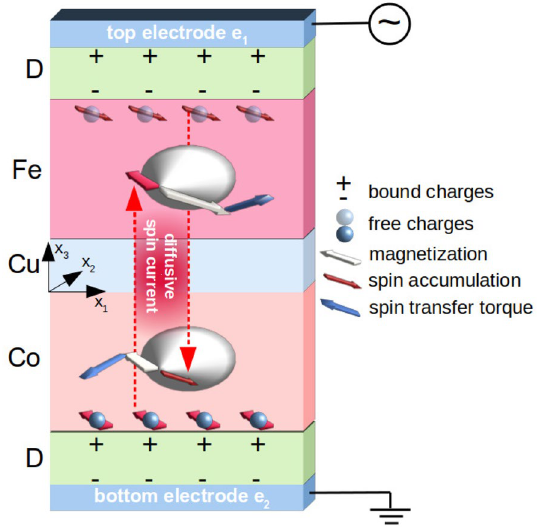
Figure 1. The principle of operation of magnetoelectric cell subjected to the ac voltage. The spin-dependent surface screening at the Fe/dielectric and Co/dielectric interfaces generates the spin accumulation which diffuses through the Fe/Cu/Co layers and exerts the spin-transfer torque on the local